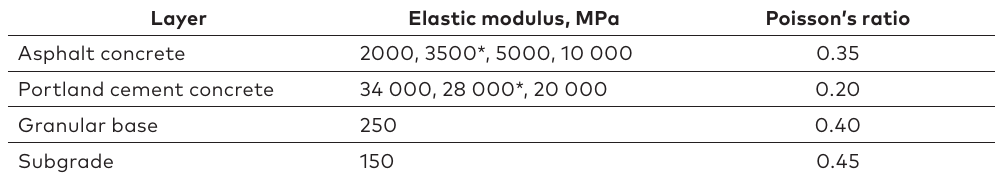
Table 1. Properties of the